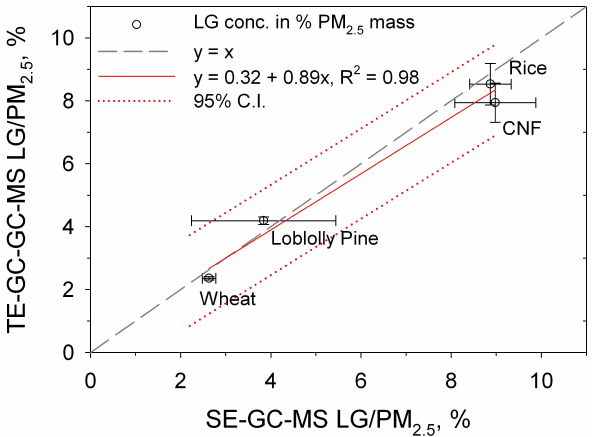
Fig. 3. Comparison of SE-GC-MS and TE-GC-GC-MS-determined LG concentrations [LG/PM 2 . 5 mass (w/w)] in four unique biomass burning aerosols. The reduced major axis linear fit (solid line), 95% confidence band (dotted lines), and 1:1 line (long dashed line forced through (0,0) are shown. The error bars reflect one standard devia- tion based on triplicate